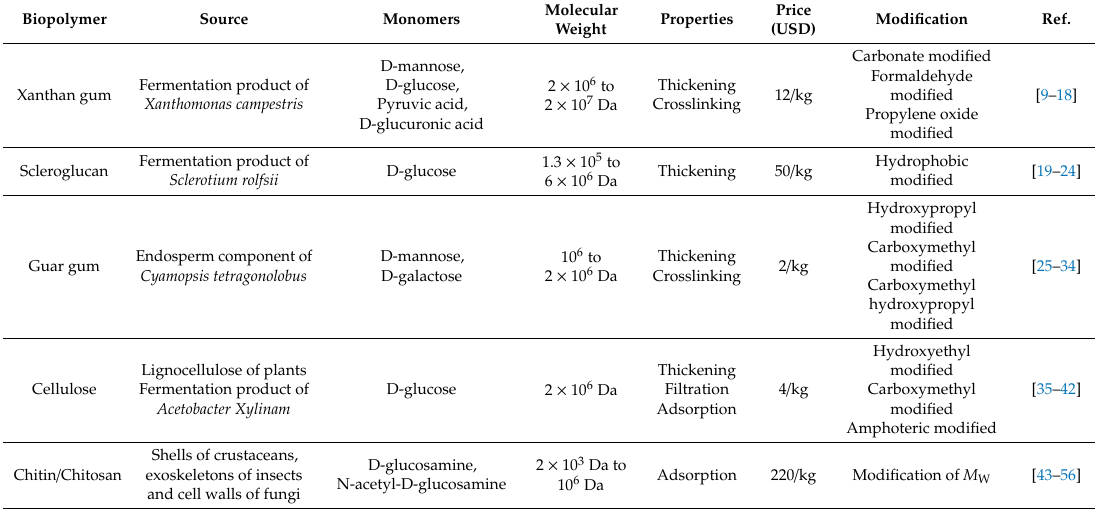
Table 1. Characteristics of biopolymers involved in petroleum